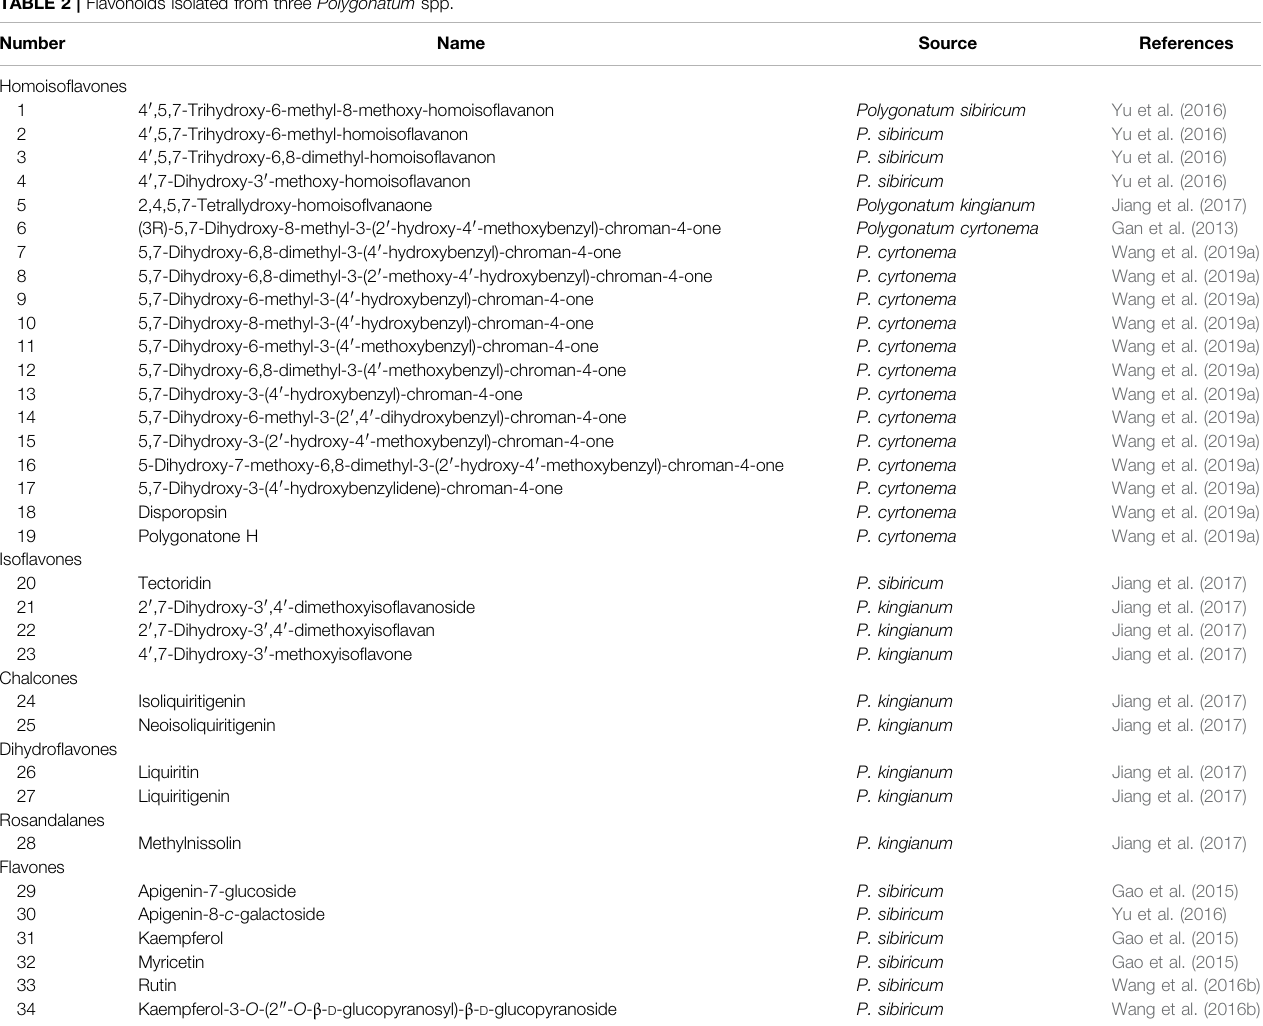
TABLE 2 | Flavonoids isolated from three Polygonatum